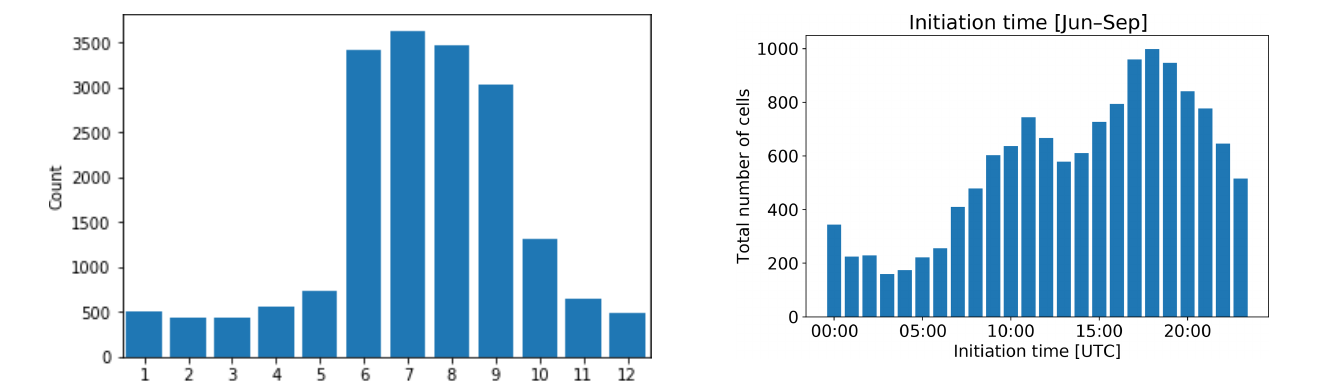
Figure 12. Total number of isolated cells that initiated within a 200km range of the KHGX radar as a function of time of day dur- ing June through September of 2015–2017. The peak at 18:00UTC corresponds to 13:00local time.